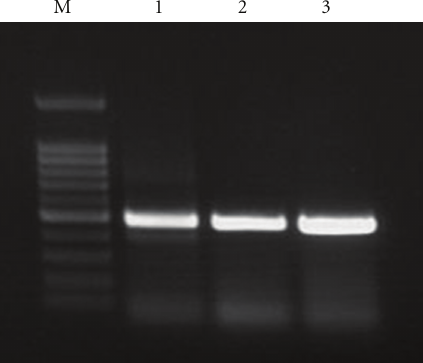
Figure 1: Detection of histamine H1 receptor mRNA by RT-PCR for 40 cycles of amplification from inferior turbinate, primary cultured human nasal epithelial cells, and primary cultured human vascular endothelial cells. RNA was extracted, RT-PCR performed using H1 receptor primers, demonstrating 497bp fragment. Lane M: 100 bp ladder. Lane 1: PCR products from total RNA of human inferior turbinate. Lane 2: PCR products from total RNA of primary cultured human nasal epithelial cells. Lane 3: PCR products from total RNA of primary cultured human nasal vascular endothelial cells.